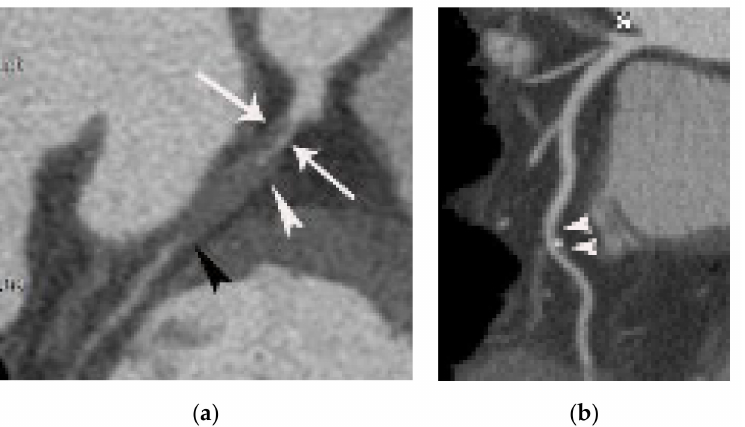
Figure 2. Difference between culprit ( a ) and nonculprit plaque ( b ) on coronary CTA. ( a ) Note the total occlusion (arrowheads) by noncalcified plaque with vulnerable CT features (positive remodeling and napkin ring sign appearance (arrows)) in the proximal left circumflex artery in a patient with AMI, showing it to be the culprit lesion. ( b ) In contrast, <50% stenosis with mixed plaque without vulnerable CT features (arrowheads) is noted in the mid left anterior descending coronary artery in a nonculprit